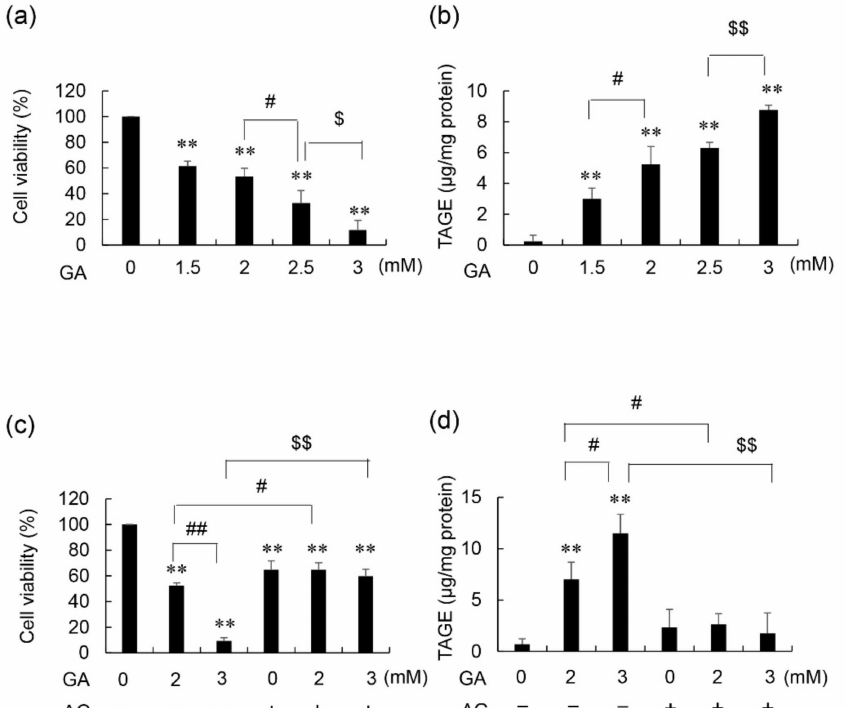
Figure 1. Viability and intracellular TAGE levels in glyceraldehyde (GA)- and aminoguanidine (AG)- treated 1.4E7 cells. ( a , b ) Effect of treatments with 0–3 mM GA for 24 h. ( c , d ) Effects of pretreatments with 0 or 16 mM AG for 2 h, followed by 0–3 mM GA for 24 h. ( a , c ) Cells were seeded in five wells and the average was calculated. The CellTiter-Glo luminescent assay was performed to evaluate cell viability in three independent experiments. Data are shown as the mean ± S.D. ( n = 3). ( b , d ) A slot blot (SB) analysis was performed to assess intracellular TAGE. Cell lysates (Two µ g of proteins per lane) were blotted onto polyvinylidene difluoride (PVDF) membranes. TAGE levels were calculated using a calibration curve of TAGE-modified bovine serum albumin (TAGE-BSA). The SB analysis was conducted in three independent experiments. One experiment was performed using two lanes and the average was calculated. Data are shown as the mean ± S.D. ( n = 3). p -values were based on Tukey’s test. ( a ) ** p < 0.01 vs. 0 mM GA. # p < 0.05 vs. 2 mM GA. $ p < 0.05 vs. 2.5 mM